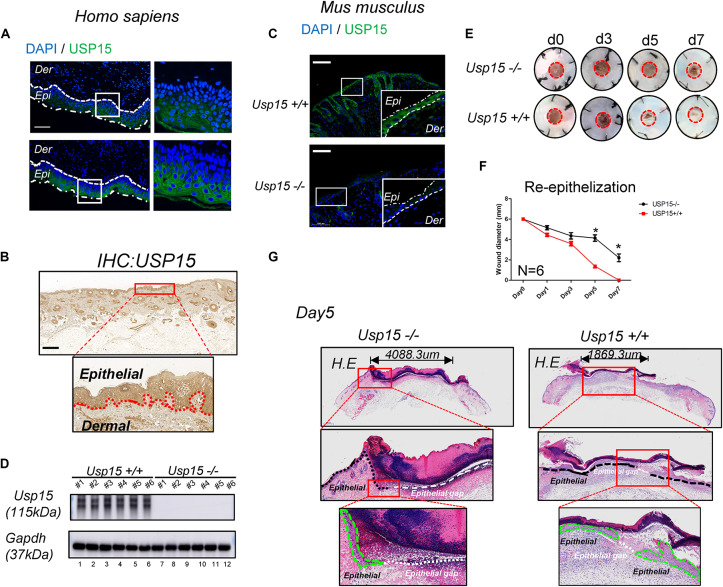
Delayed re-epithelialization in USP15–/– mice. (A,B) Immunofluorescence (A) and immunohistochemistry (B) of USP15 in human normal full-layer cutaneous tissue. Green: USP15; Blue: DNA; Scale bar: 50 μm. (C) Immunofluorescence of Usp15 in mouse normal cutaneous tissue. Green: Usp15; Scale bar: 50 μm. (D) Western blot assays were performed to measure Usp15 expression in the Usp15–/– animals and their wild-type littermates. Numbers of mice in each group: 6. (E,F) An excisional wound splinting model was established to evaluate the re-epithelialization rate in the USP15 knockout (KO) mice. Red circle: 6 mm diameter. *p < 0.05. Numbers of mice in each group: 6. (G) Haematoxylin-eosin staining revealed the epidermal gap in the excisional wound splinting model of the USP15 KO mice and their wild-type littermates. Black dash line: basal cell. Green dash area: regenerated epithelial. White dash line: the gap between regenerated epithelium of the wound area.